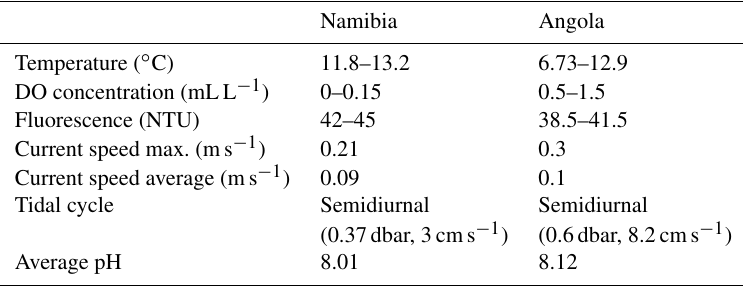
Table 2. Environmental properties at the Namibian and Angolan margins.